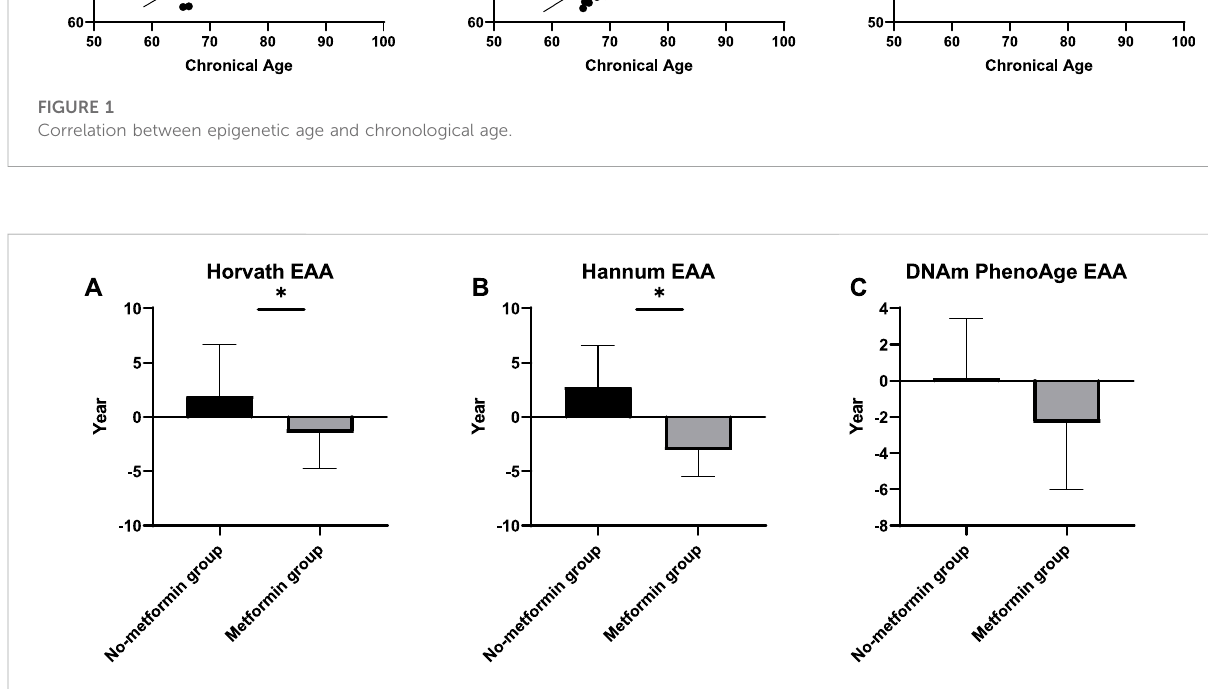
FIGURE 2 Epigenetic Age Acceleration of the two groups by the three epigenetic